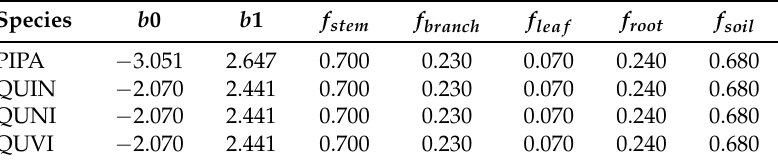
Table A17. Species biomass equation parameters.